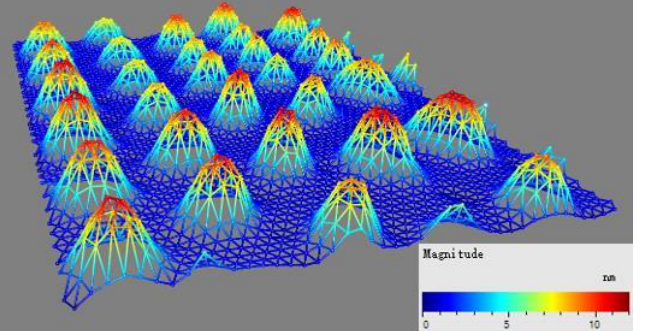
Figure 5. Laser vibrometer measurement of the CMUT: 2D scan of the membrane displacement un- der 1 Vpp sinusoidal signal at its resonance. 1 Vpp sinusoidal signal at its